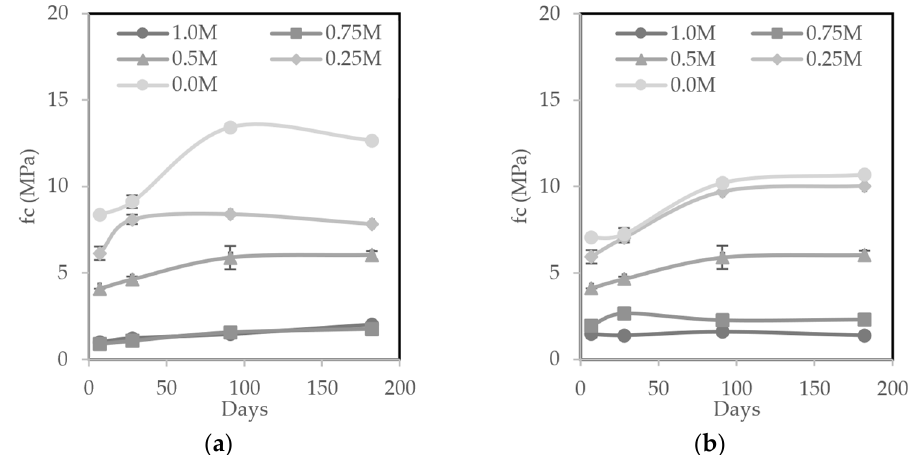
Figure 10 . Flexural strength of: ( a ) OAA mortars and ( b ) CAA mortars. Figure 10. Flexural strength of: ( a ) OAA mortars and ( b ) CAA mortars.